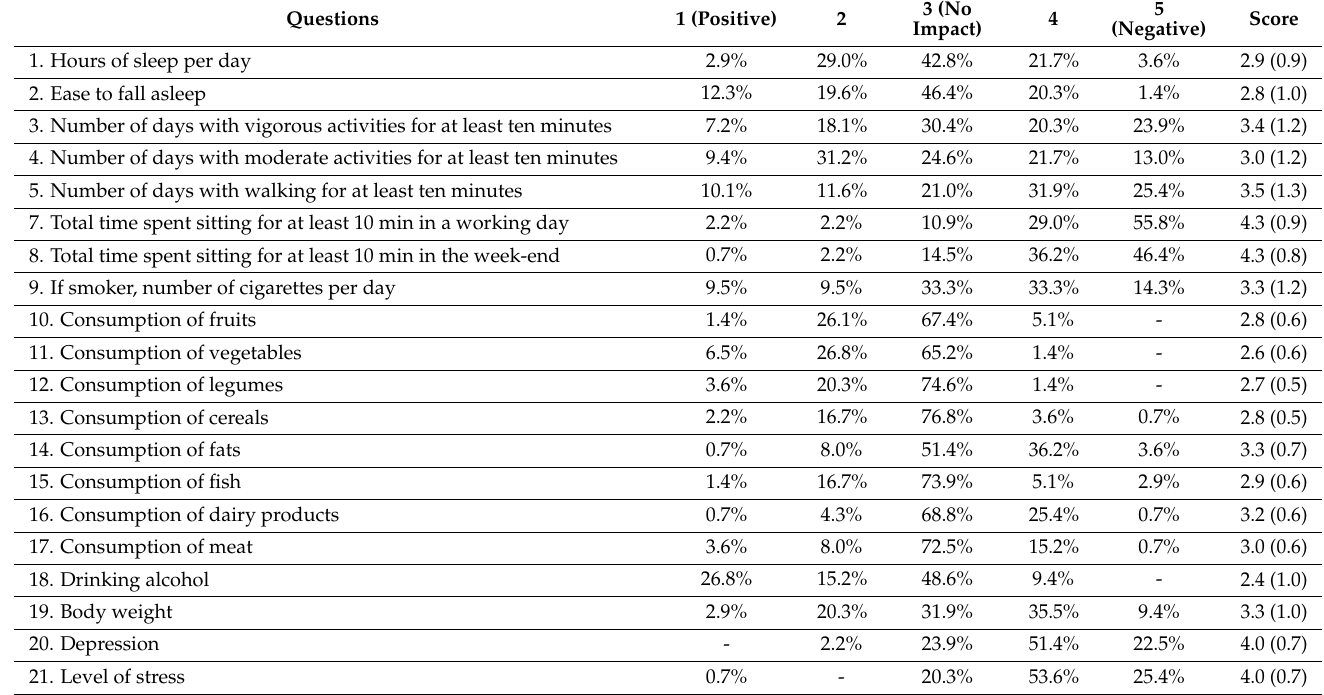
Table 3. The impact of the COVID-19 pandemic on